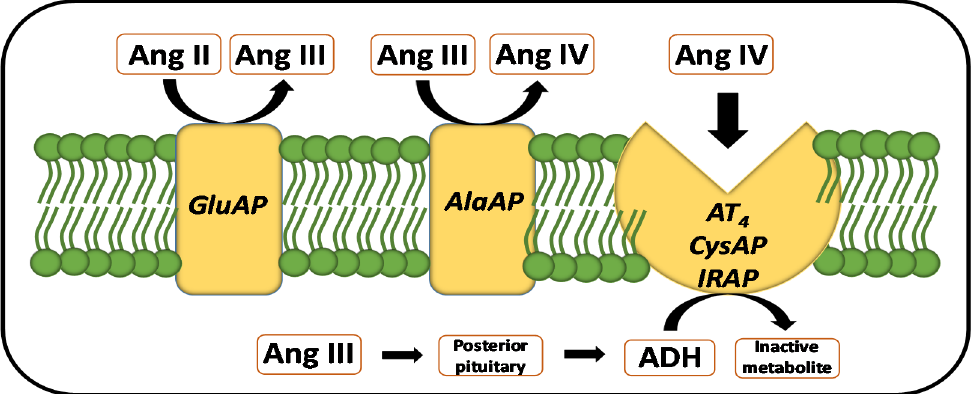
Figure 1. Partial representation of the renin-angiotensin system in which the hydrolytic and receptor function of the enzymatic activities (determined in the present work) is shown. Angiotensin II (Ang II) is hydrolyzed to Ang III by glutamate aminopeptidase (GluAP) and Ang III will be hydrolyzed to Ang IV by alanine aminopeptidase (AlaAP). Ang IV can bind to the AT 4 receptor, reported as identical to the insulin-regulated aminopeptidase (IRAP) or vasopressinase, whose activity can be measured as cystine aminopeptidase (CysAP). In addition, the stimulatory role of Ang III on the posterior pituitary for antidiuretic hormone (ADH) secretion has been also reported [5–9].